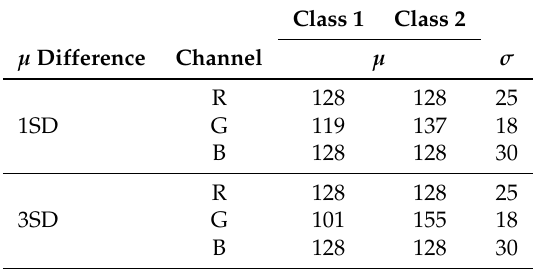
Table 2. Parameters of each color channel per